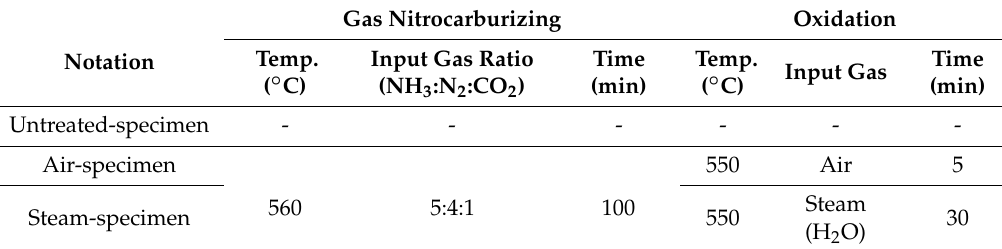
Figure 1. Schematic diagram of the surface heat treatment process in this study. Table 2. Notation and conditions of oxi-nitrocarburizing for each specimen.